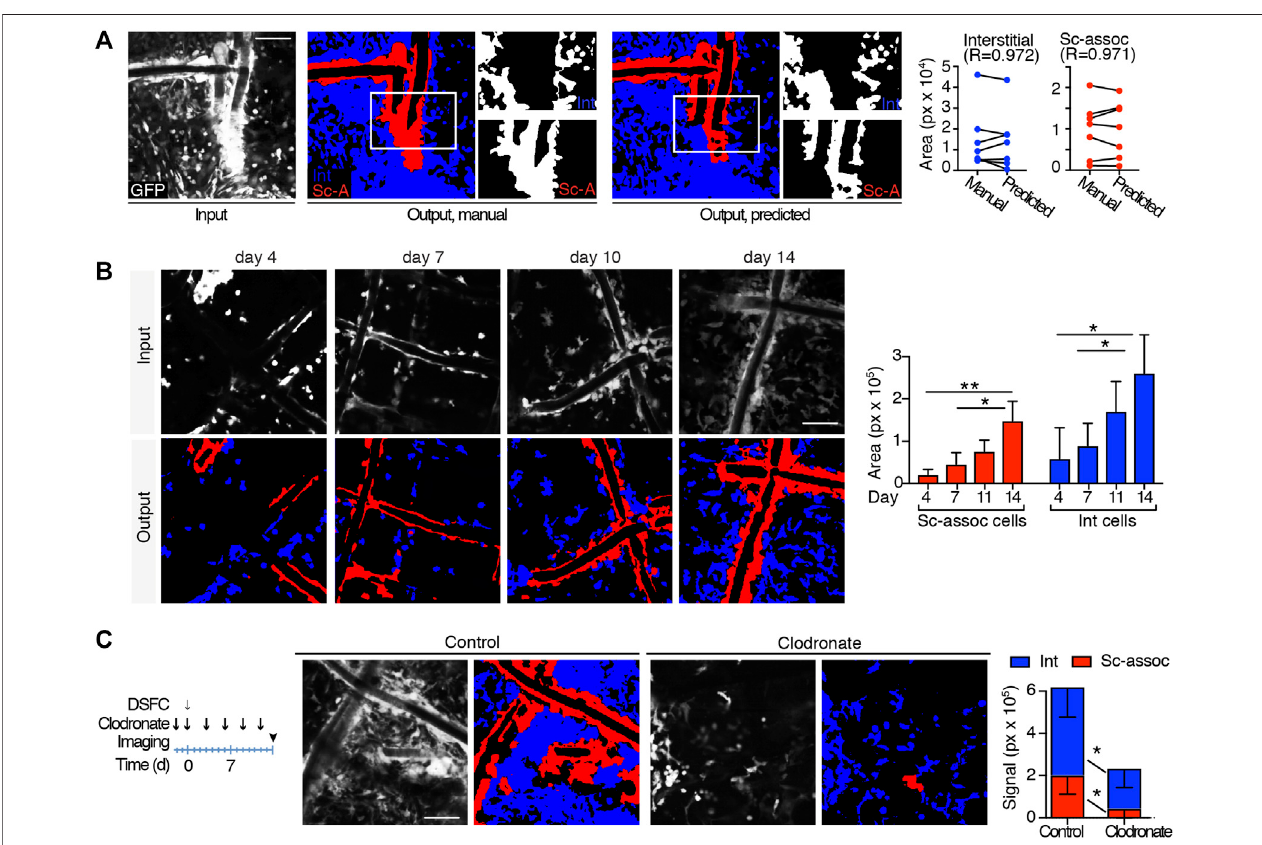
FIGURE 3 | Automatic quanti fi cation of scaffold-associated and interstitial cells. (A) Segmentation of scaffold-associated cells (red), interstitial cells (blue), and background (black). Left panel, preprocessed input image; central panel, target manual label; right panel, predicted output mask. Insets show single binary masks for interstitial and scaffold-associated (sc-assoc) cells. Pearson correlation between the area of interstitial and scaffold-associated cells in both manual and predicted outputs(obtainedfrom7independentimages)isshown. (B) Automaticquanti fi cationofsc-associatedandinterstitialcells4,7,11,and14 dayspost-implantation. Representative images of the GFP-positive cells at the implantation site at all the time points (input), together with their predicted output masks (output) are shown. Histograms quantify the area of sc-associated and interstitial cells at each time point. ( n (cid:1) 4 mice, 3 images/mouse). * p < 0.05, ** p < 0.01 (unpaired two-tailed Student t -test).Scalebar,100 μ m. (C) Automaticquanti fi cationofsc-associatedandinterstitialcellsinuntreatedandclodronateliposome – treatedmiceatday14.Thetreatment and imaging schedule is shown. Input representative images and their output masks of FBR in control and clodronate-treated mice are shown. Histograms represent area quanti fi cation for sc-associated and interstitial cells in control and treated mice. ( n (cid:1) 4 mice/group, 3 images/mouse). * p < 0.05, ** p < 0.01 (unpaired two-tailed Student t -test). Scale bar, 100 μ